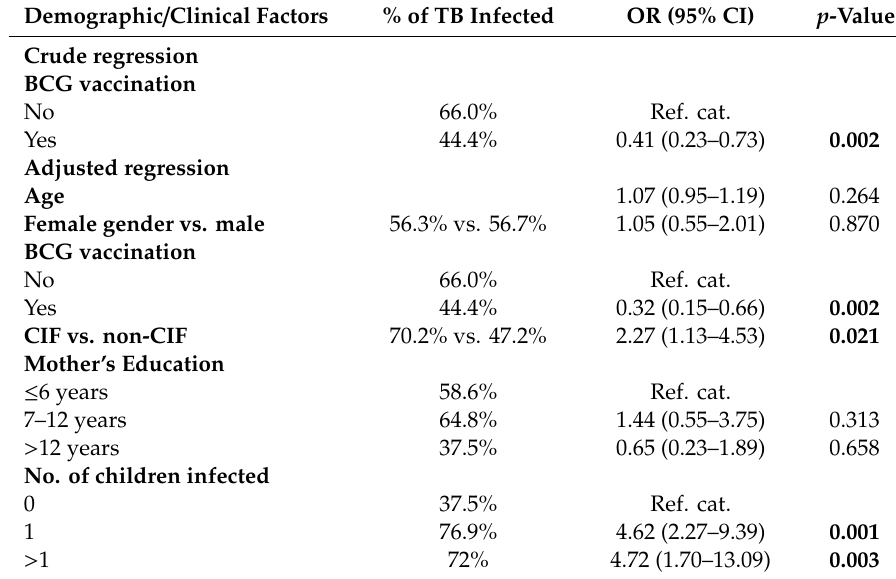
Table 3. Multiple logistic regression of factors associated with TB infection among children > 5 years of age exposed to an infectious adult index